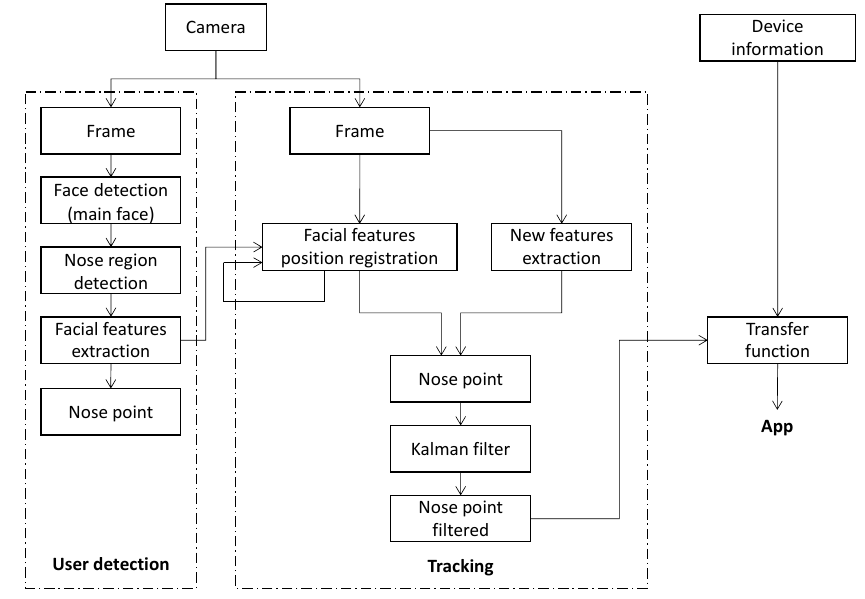
Figure 1. Camera-based interface design.